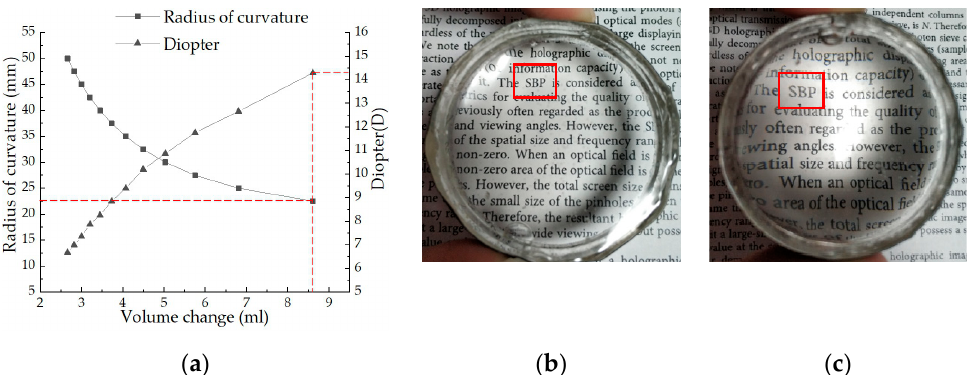
Figure 4. Variable-focus liquid lens: ( a ) Curves of the radius of curvature and the diopter of liquid lens with the variation in the volume change; ( b ) imaging effect at 0D; ( c ) Imaging effect at 14.29D.